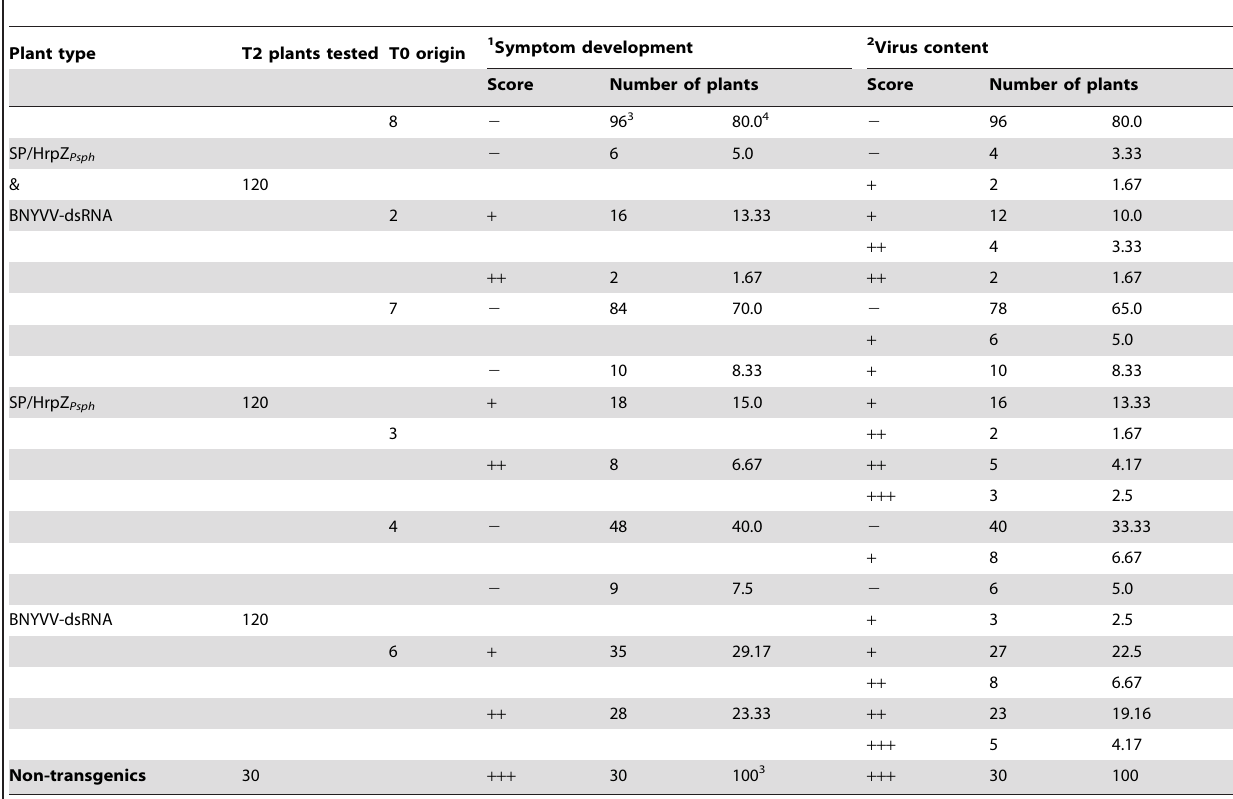
Table 1. Symptom severity and virus titer of transgenic N. benthamiana T2 plants expressing SP/HrpZ Psph and BNYVV-derived dsRNA in comparison to T2 plants expressing either SP/HrpZ Psph or BNYVV-derived dsRNA, 30 days after challenge with BNYVV.